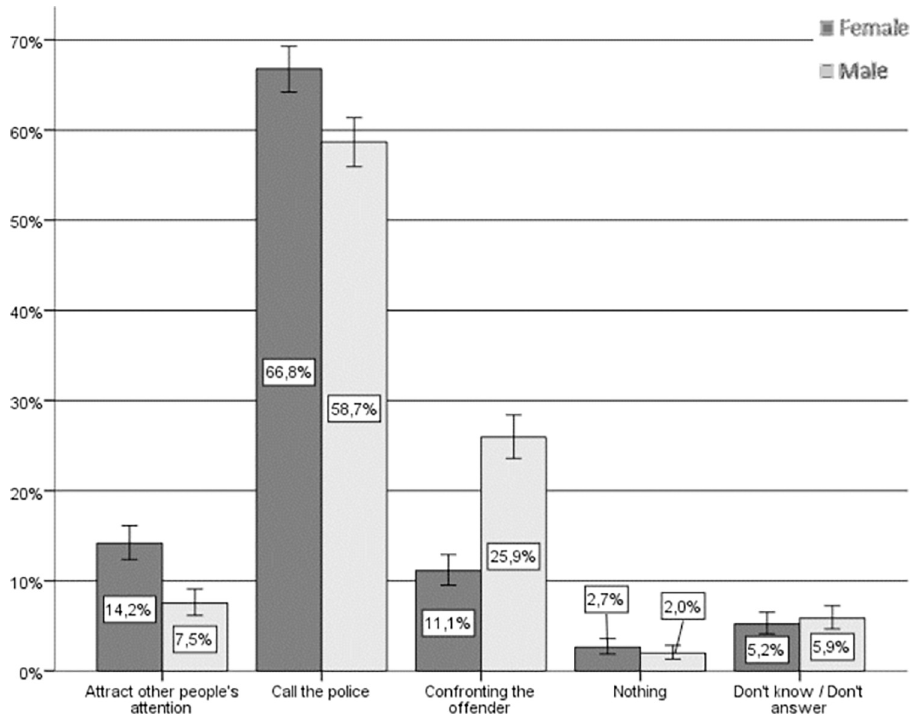
Fig 6. Hypothetical response to IPVAW among young people by sex. Source: Own elaboration based on CIS study 2992 [49] question 14. 95% confidence intervals are provided for each subsample.